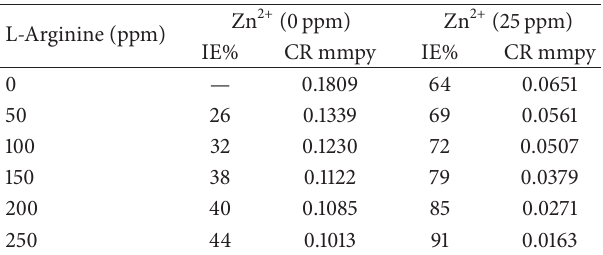
Table 2: Inhibition efficiencies (IE) and corrosion rates (CR) obtained from L-Arginine-Zn 2+ systems, when the carbon steel was immersed in sea water.